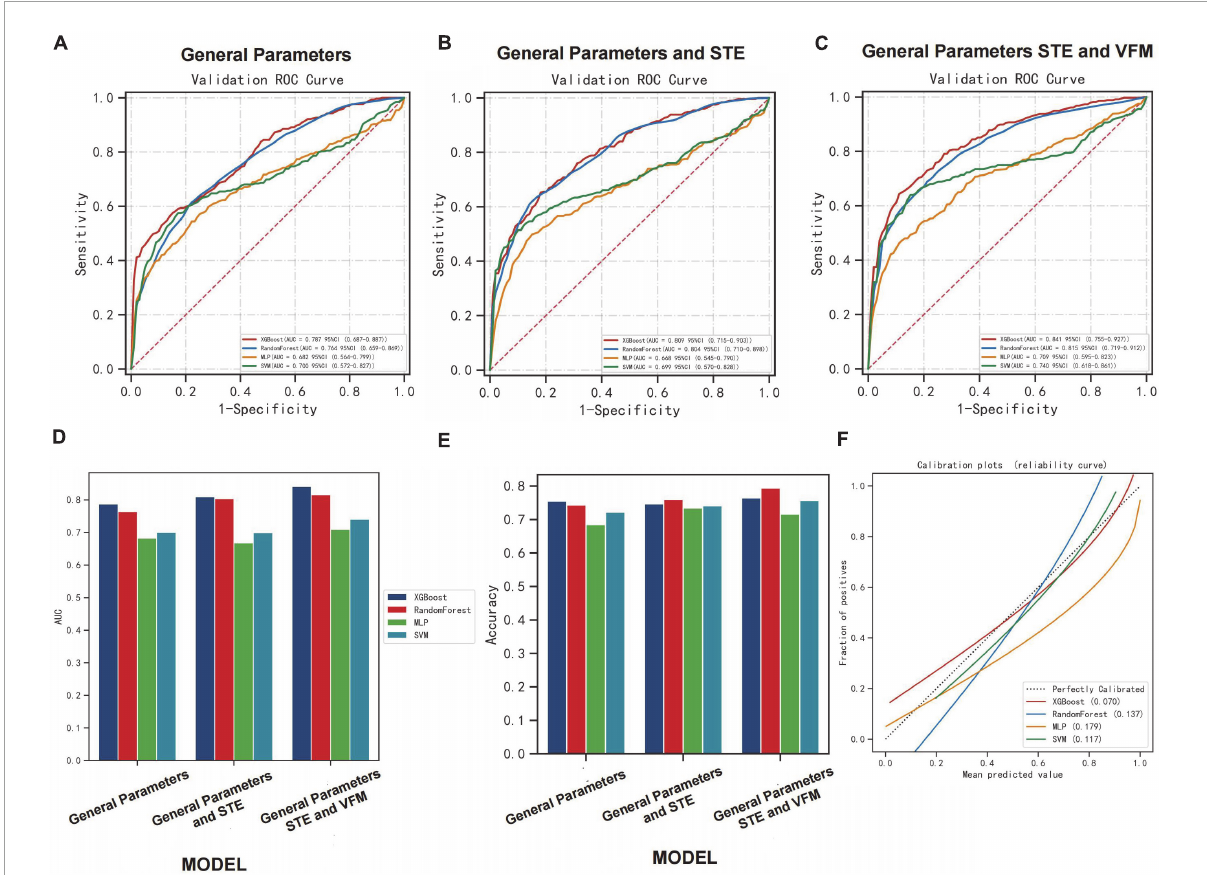
FIGURE7 Performance of machine learning algorithms among the groups. (A–C) The ROC curve of the model performance in classifying patients correctly in each group using learning algorithms. (D,E) The performances [area under curve (AUC) and accuracy] of the model in classifying patients correctly in each group using learning algorithms. (F) The calibration plots of learning algorithms in group [General Parameters, speckle tracking echocardiography (STE) and vector flow mapping (VFM)